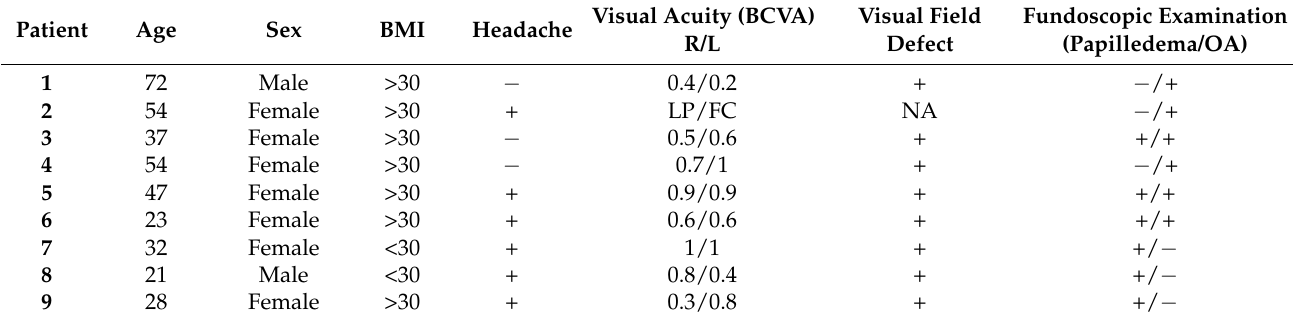
Table 1. Demographic and preoperative clinical features of patients.